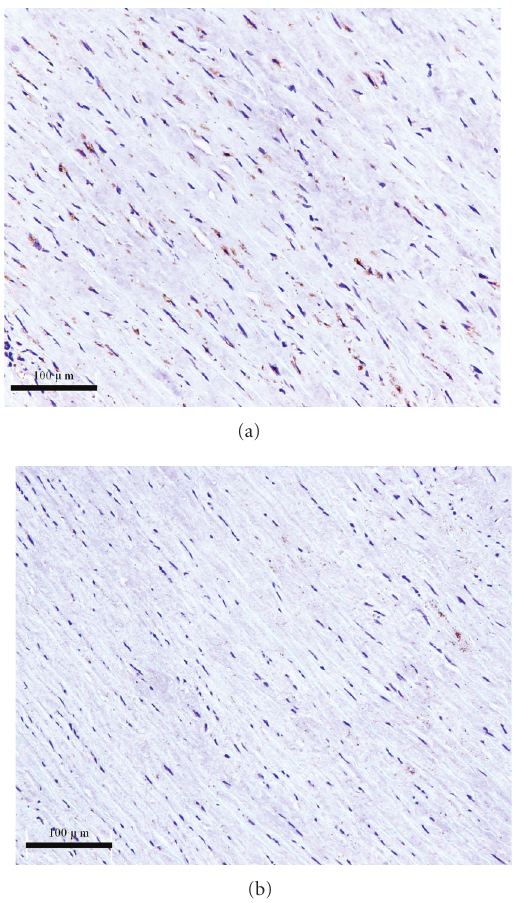
Figure 5: Representative staining pictures of S1P3 in AAA and control aortic sections ( × 200). More S1P3 protein was found in the AAA (a) than that in the normal aortas, in which it was almost